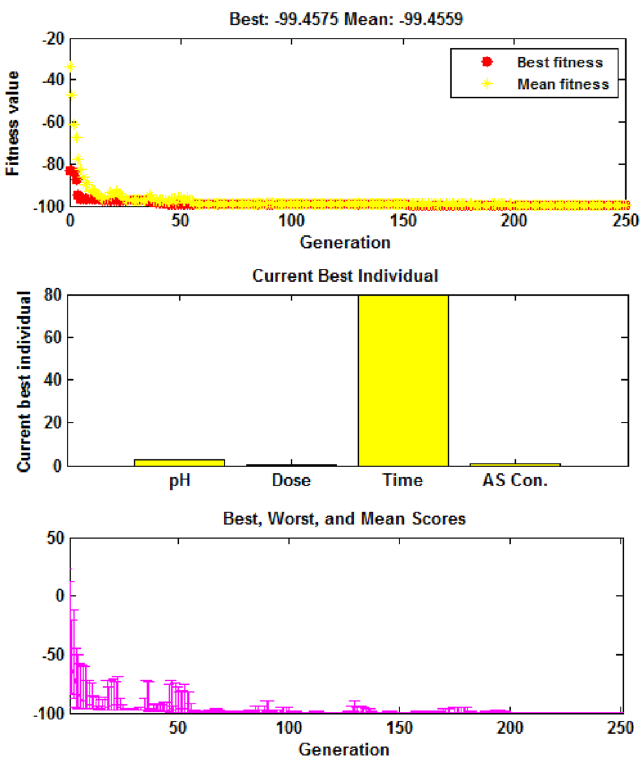
Figure 5. Output of GA method for optimization of independent variables in As(V) adsorption process on amino-MIL-68(Al). MATLAB R2013a software was used to create this figure (https:// www. mathw orks. com/ produ cts/ matlab.